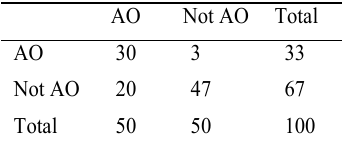
Table 6. Confusion matrix for the best binary SVM autumn olive classified map which had a polynomial